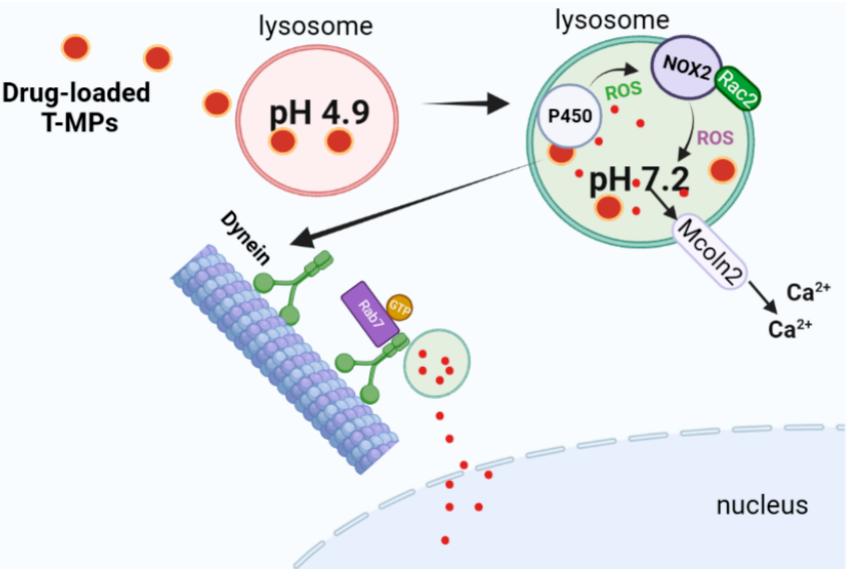
Figure 2. Drug-loaded T-MPs deliver drugs into the nucleus based on [54] (Signal transduction and targeted therapy, 2023).